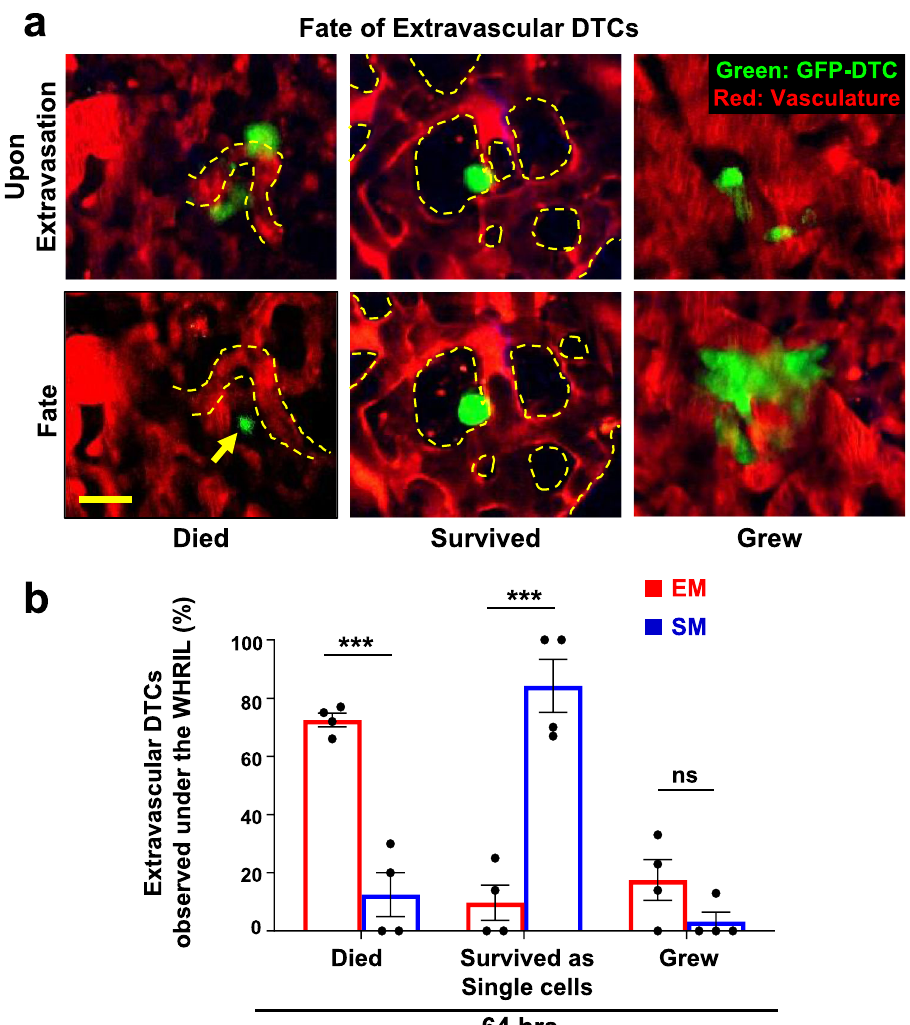
Fig. 3 Spontaneously metastasizing tumor cells survive signi fi cantly longer at the secondary site compared to intravenously injected tumor cells. a Representative intravital microscopy images showing the possible fates of extravascular disseminated tumor cells in the lung parenchyma. Top: Images of disseminated tumor cells just after extravasation. Bottom left: Example of an extravascular tumor cell, which has died, as evidenced by small extravascular apoptotic bodies (yellow arrow). Bottom middle: Example of an extravascular tumor cell that survived as a single and solitary tumor cell over time. Bottom right: Example of an extravascular tumor cell that began to divide and grow into a micro-metastasis. Red = tdTomato labeled endothelial cells and 155 kDa Tetramethylrhodamine dextran labeled blood serum, Green = GFP labeled tumor cells. Yellow dashed lines delineate blood vessel boundaries. Scale bar = 15 μ m. b Percentage of extravascular E0771-GFP disseminated tumor cells that died, survived, or grew after extravasation in EM and SM models 64 hrs after arrival to the lung vasculature. EM: n = 27 tumor cells in 4 mice. SM: n = 31 tumor cells in 4 mice. Bar = mean. Error bars = ±SEM. For Died and Survived columns, a two-tailed unpaired t-test was used ( p = 0.0003 and 0.0005, respectively). For Grew columns, a two-tailed Mann-Whitney test was used ( p = 0.14). *** p < 0.001. ns = not signi fi cant. Source data are provided as a Source Data fi